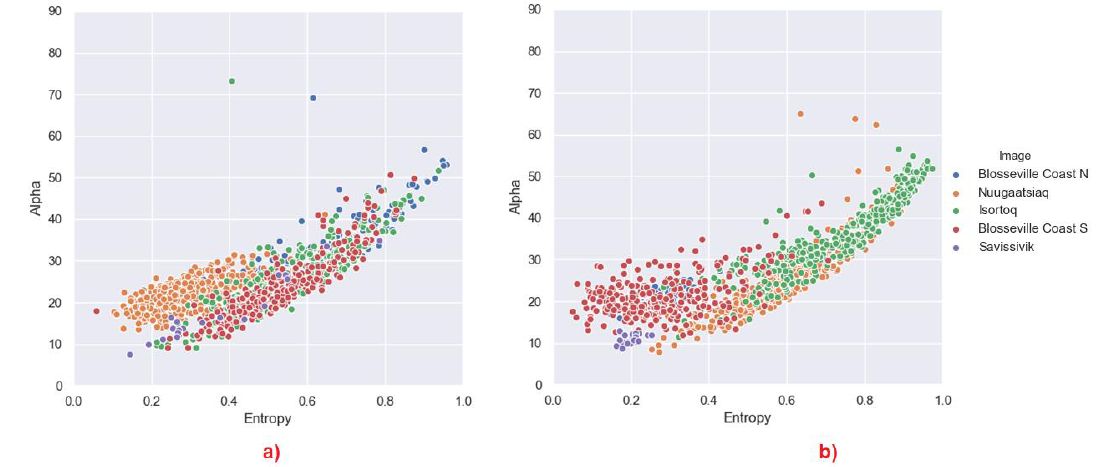
Figure 12. ( a ) Iceberg alpha, entropy plot 5 × 5 window, ( b ) 11 × 11 window. Entropy is between 0 and 1. Alpha is between 0 and 90. Colour legend indicates image. Dots indicate icebergs.